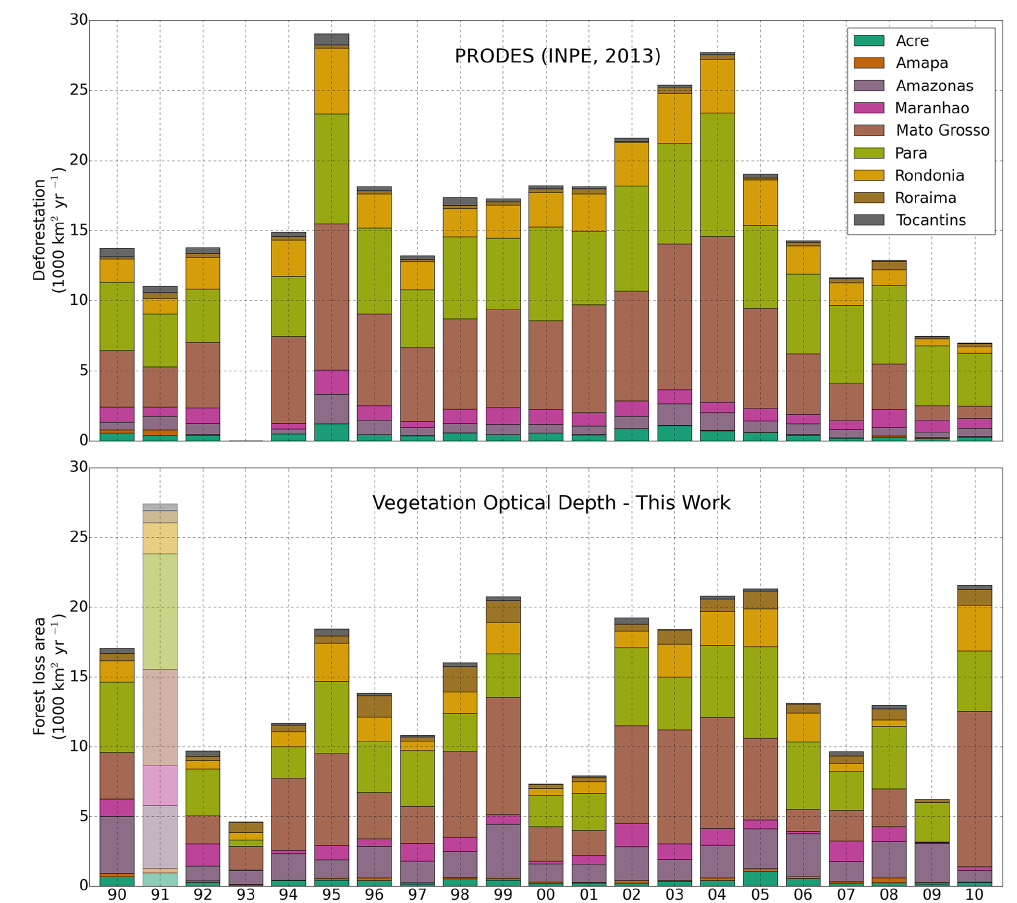
Figure 8. Time series of deforestation (PRODES) and forest loss area (VOD) for the Brazilian states in the Amazon (1990–2010). PRODES deforestation data are missing for 1993. VOD data are unreliable for 1991 as a result of the eruption of Mount